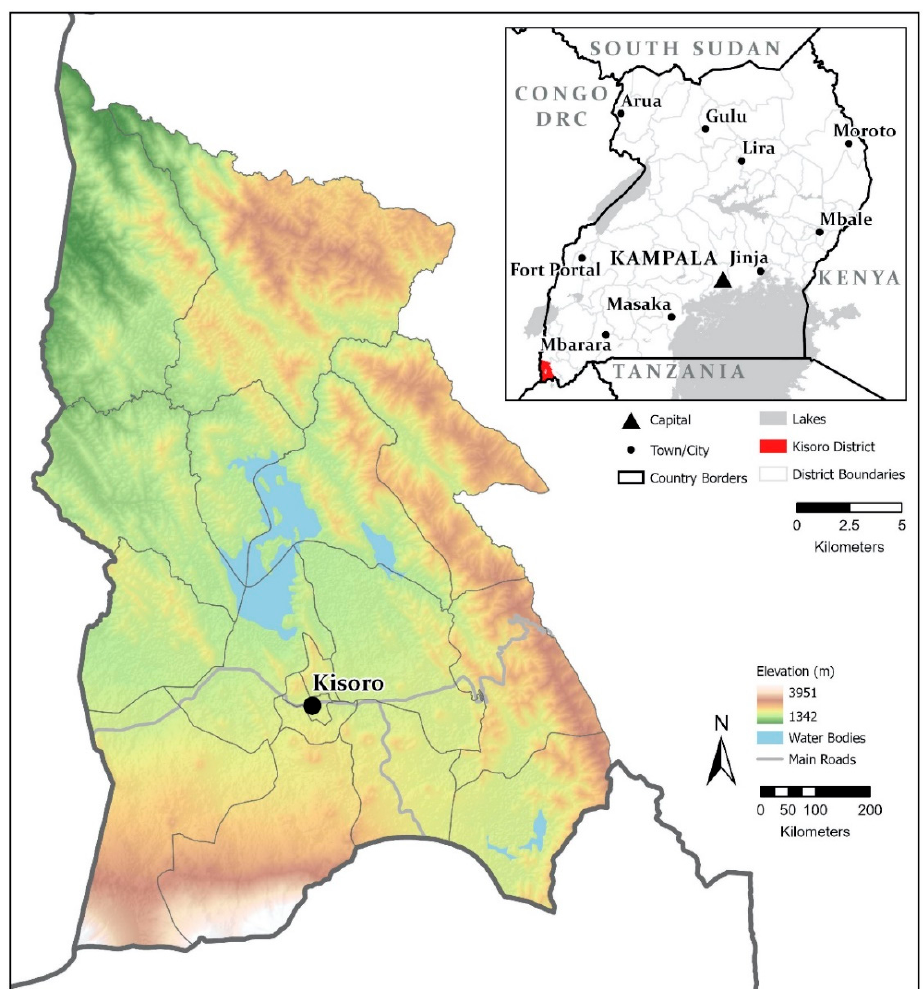
Figure 1. Map of the study area, located in the far southwest of Uganda (Source: Harry West, UWE, Bristol).